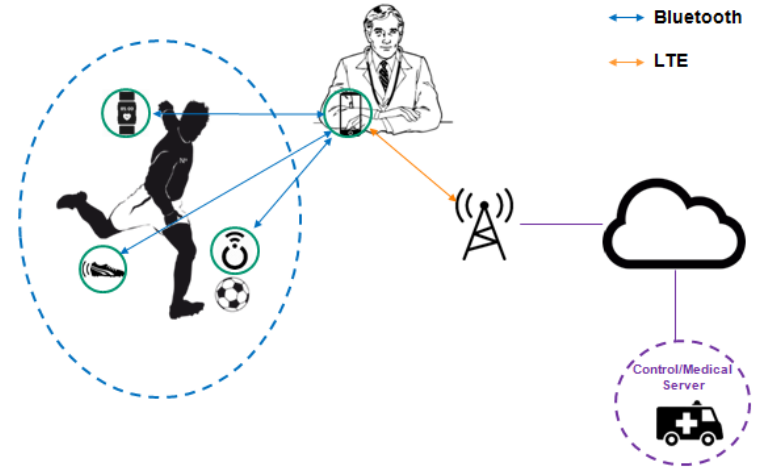
Figure 4. Illustration of an IoT network